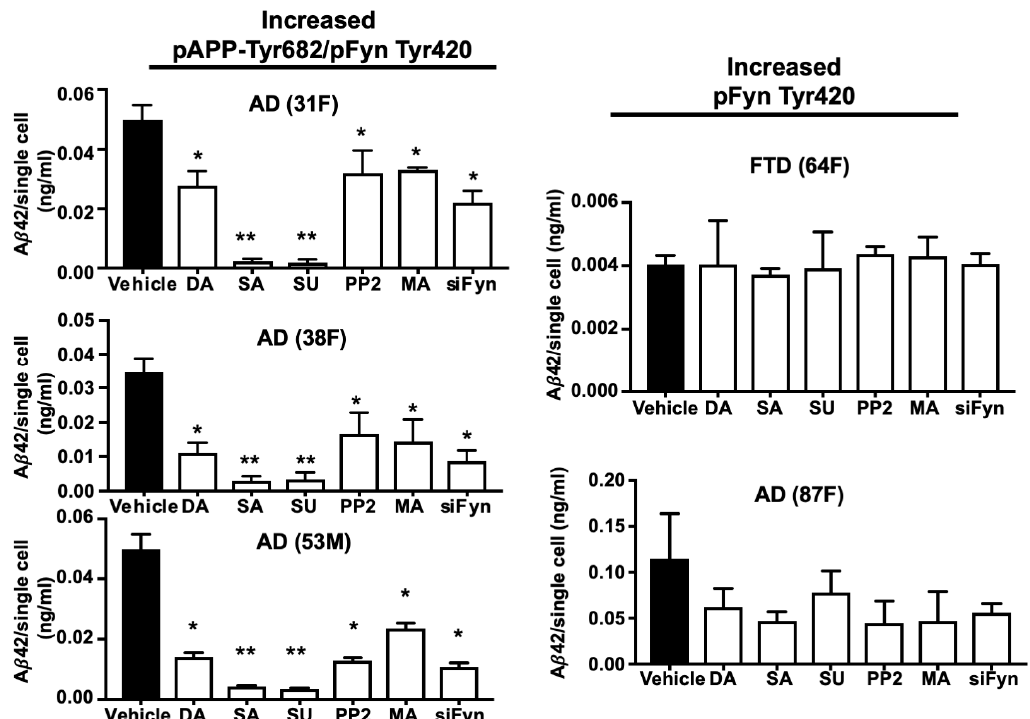
Figure 8. Fyn TKIs reduced A β 42 levels in neurons from AD patients who had high pAPP-Tyr682 levels but not in those in which pAPP-Tyr682 levels were not altered. After 5 weeks in culture, neurons were exposed to Fyn TKIs for 6 h and then left for an additional 12 h in fresh media without inhibitors, based on a previously described procedure [12]. The Fyn TKIs used in the experiments are reported in Table 2. All the inhibitors were resuspended in the same vehicle (DMSO). The following concentrations of each inhibitor were used: 10 nM saracatinib (SA), 10 nM dasatinib (DA), 150 nM SU6656 (SU), 150 nM PP2, and 100 nM masitinib (MA). A β 42 levels from neurons transfected with siFyn are also reported. A β 42 was assessed in media by ELISA. Neurons were stained with DAPI and counted. No significant alterations in neuronal survival were assessed in the presence, or not, of inhibitors (data not shown). A β 42 values (ng / mL) were calculated as a ratio of total A β 42 levels relative to the total number of alive neurons and are expressed as A β 42 levels that were released from a single cell in 0.5 mL of media. n = 3 * p < 0.05, vs. vehicle; ** p < 0.05, vs. DA. Statistical significance was calculated using one-way ANOVA followed by Dunnett’s post hoc test.